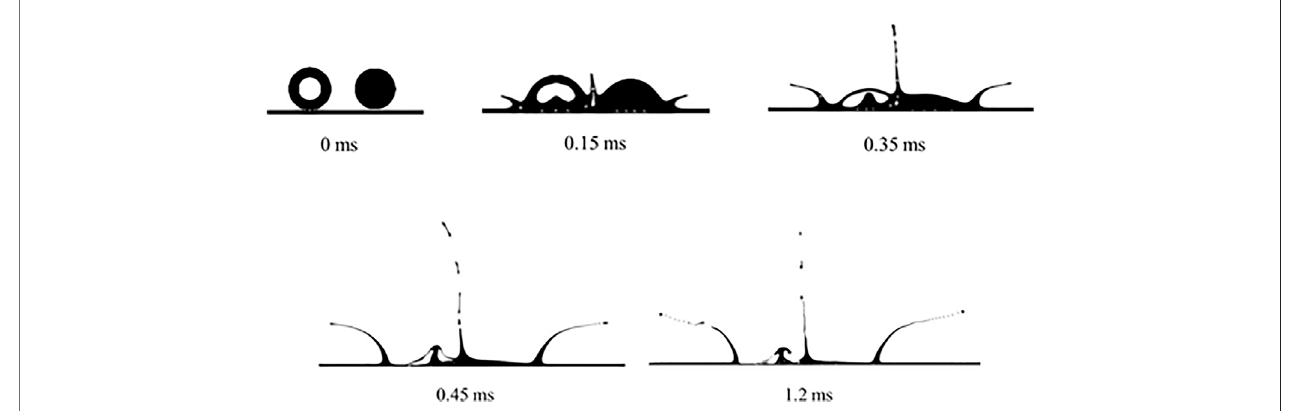
FIGURE 5 | Morphology of droplets impact on liquid fi lm at 6 m s − 1 .